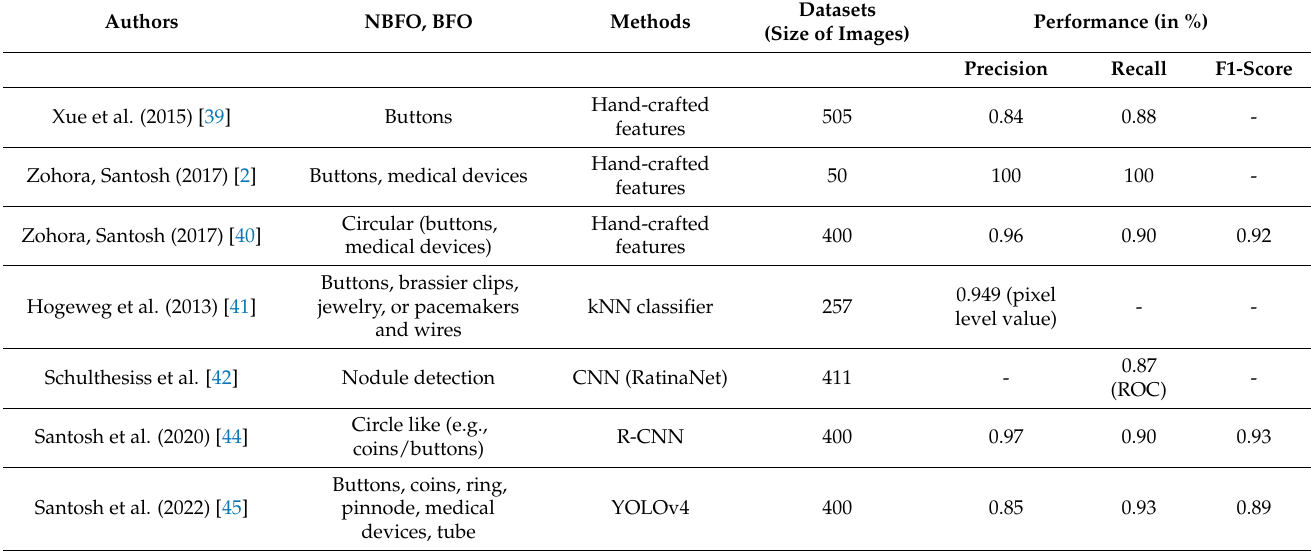
Table 2. NBFO and BFO in chest X-ray, dataset size, and performance measured in Performance, Recall,